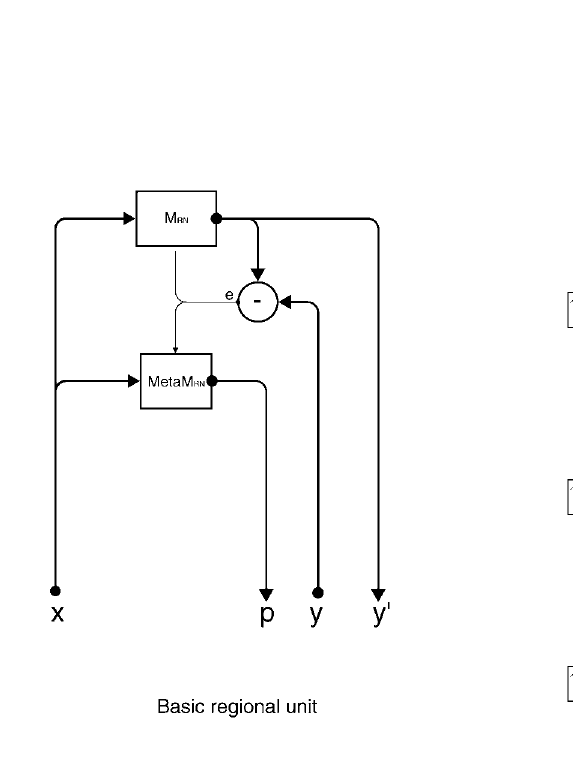
modelling the learning n